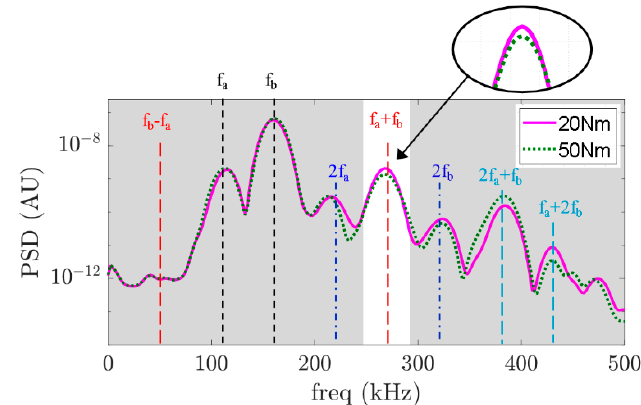
Figure 7. PSD comparison between two different applied torques.